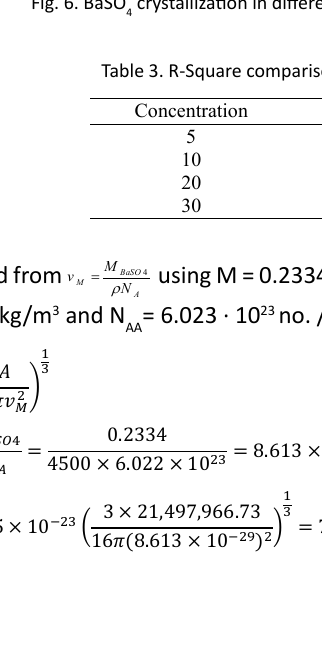
SO concentrations based on secondary nucleation theory 2 4